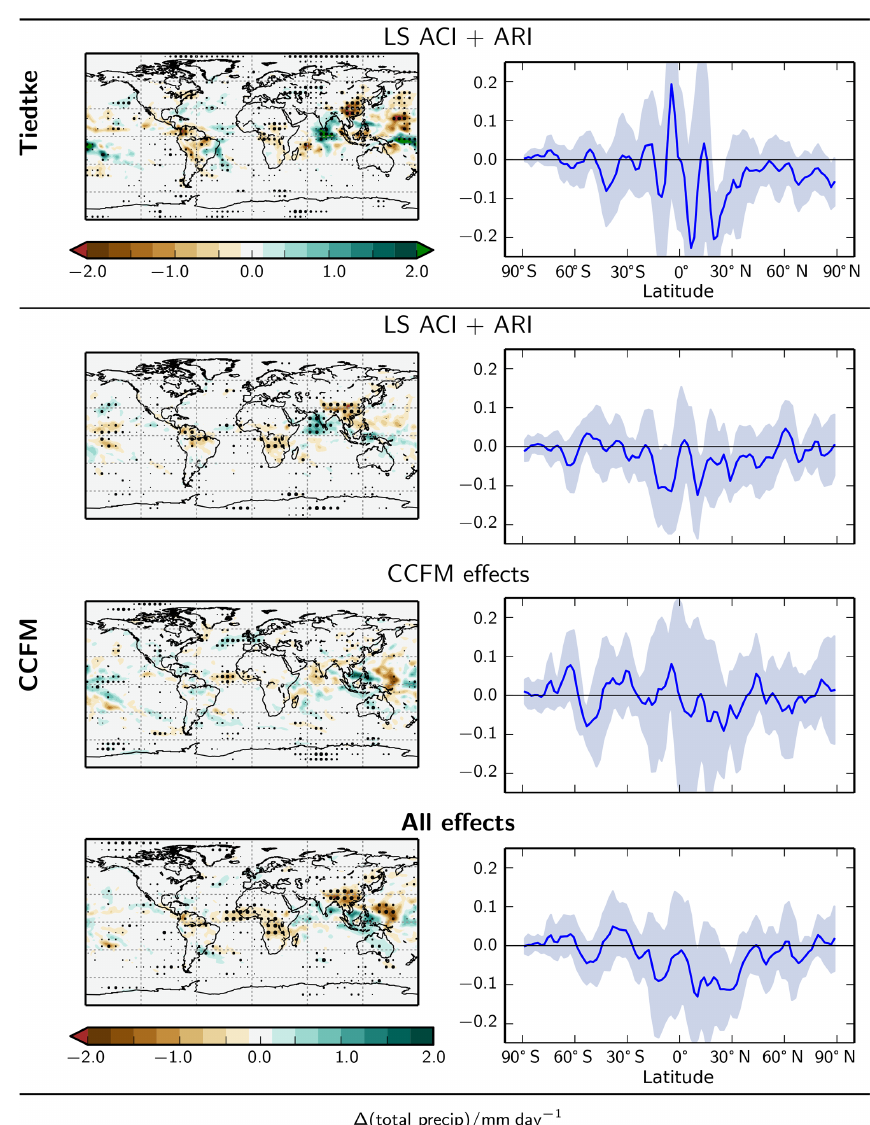
Figure 2. Annual mean precipitation response (PD–PI) in ECHAM–HAM with Tiedtke (top) and CCFM (below) convection, with the latter decomposed into large-scale and convective mechanisms as listed in Table 2. The plots on the right-hand side show the zonal mean of the maps on the left. A further breakdown into individual process effects is included in the Supplement. (PD: present-day aerosol; PI: pre- industrial aerosol; stippling indicates areas where the PD–PI difference is statistically significant at the 95% level, while the corresponding confidence interval is shaded on the zonal mean